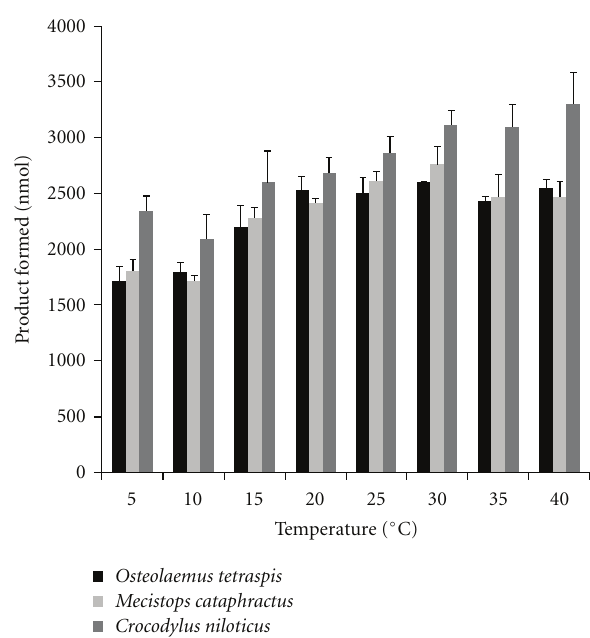
Figure 4: Serum PLA 2 activity of Osteolaemus tetraspis , Mecistops cataphractus , and Crocodylus niloticus at di ff erent temperatures. The results represent the means ± standard deviations of four independent determinations.